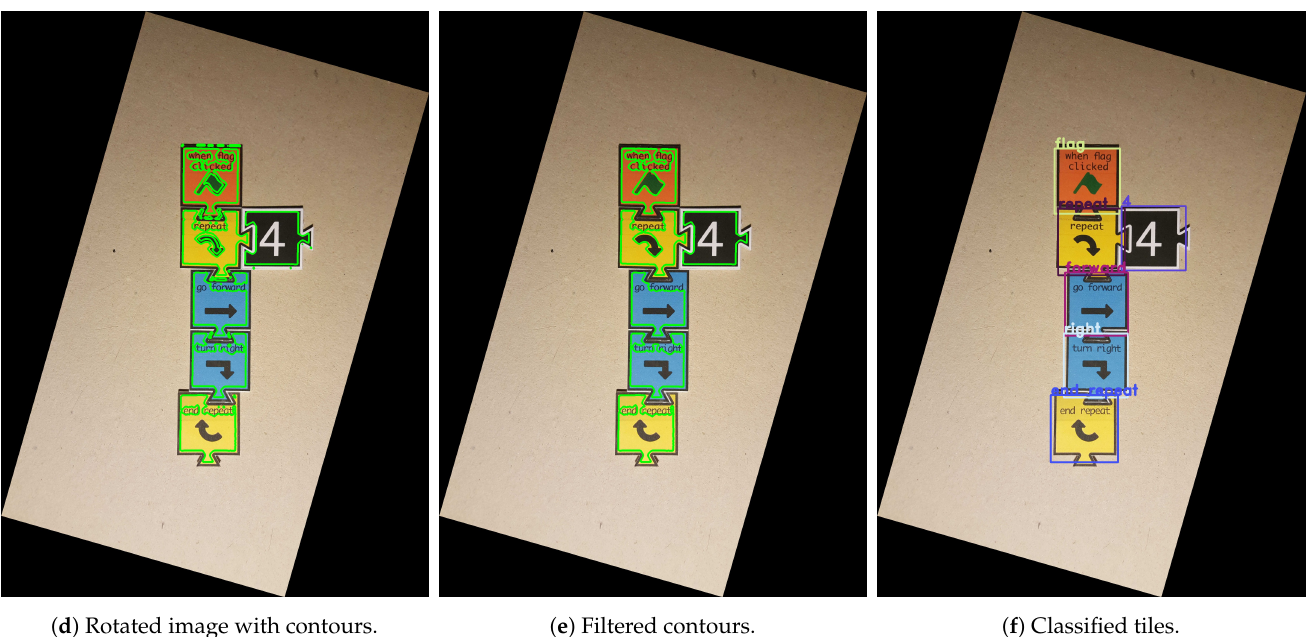
( d ) Rotated image with contours. ( e ) Filtered contours. ( f ) Classified tiles. Figure 3. Use case of the processing pipeline: the input image is ( a ) resized, ( b ) adjusted, ( c ) binarised and rotated, and ( d ) the most relevant contours are obtained and ( e ) filtered; then, each contour bounding box is extracted and ( f )